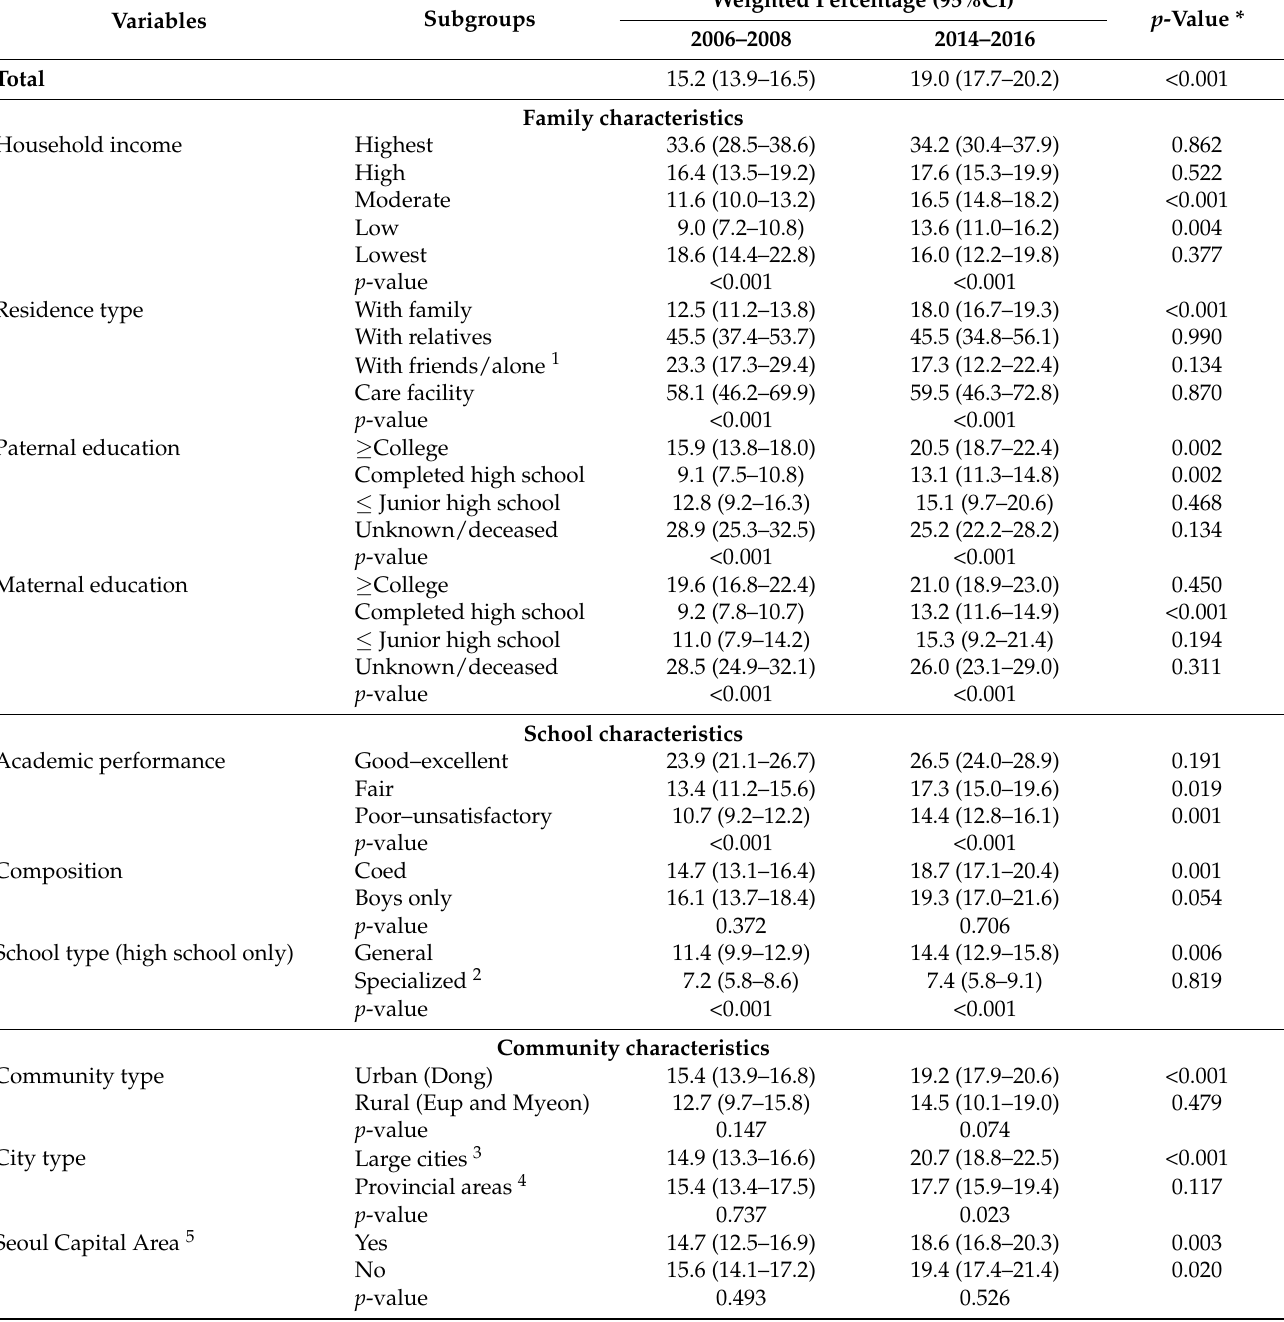
Table 2. Weighted percentage of boys reporting early sexual